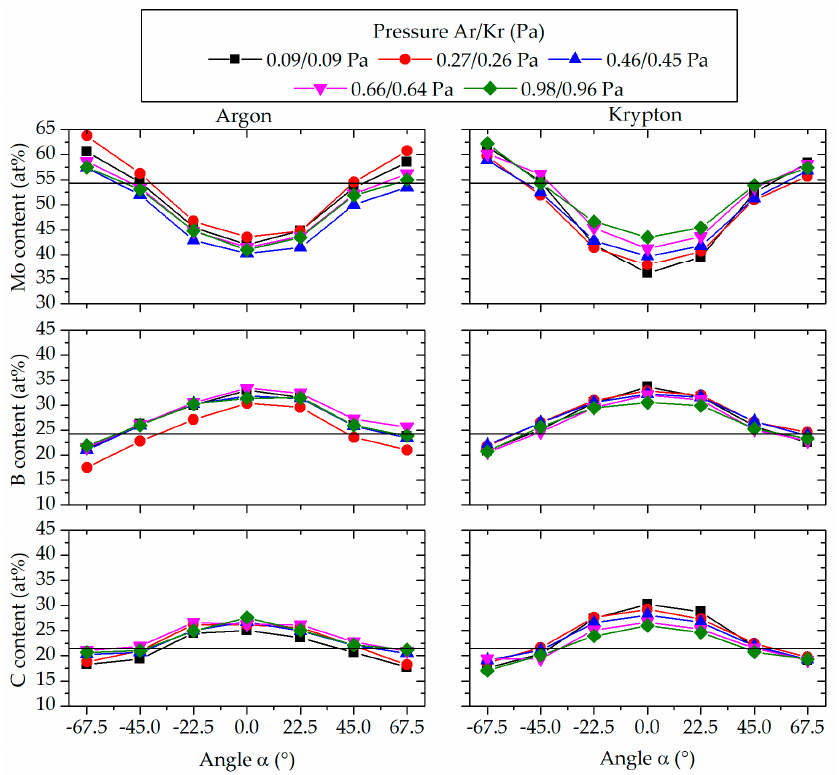
Figure 4. Angle-resolved composition evolution of the deposited thin films within the pressure range from 0.1 to 1.0 Pa. The first pressure value pertains to the Ar depositions, the second value to the Kr depositions. The average oxygen content was less than 1.5 at.% for all depositions and not considered further. The target composition is marked by the black horizontal lines.